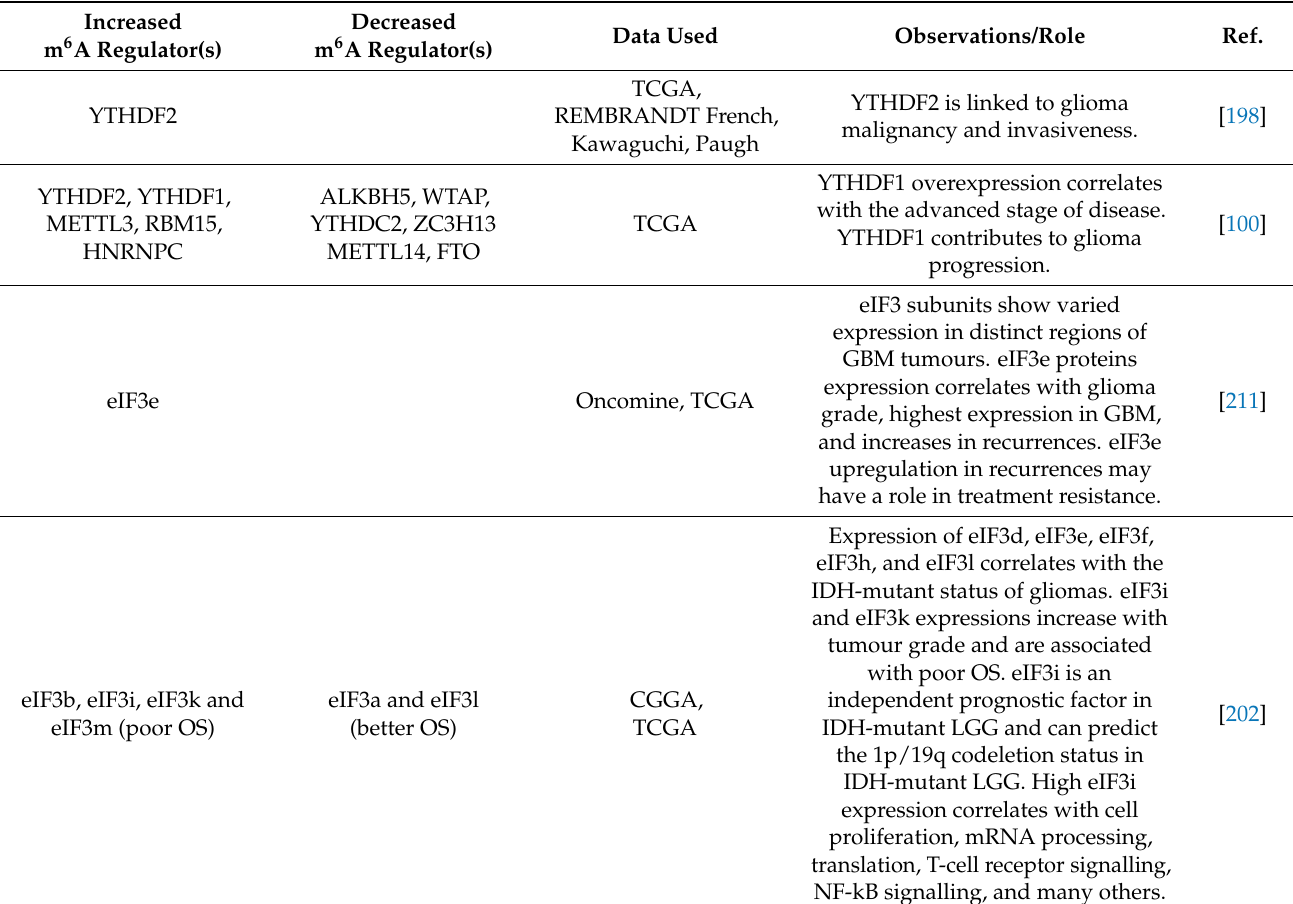
Table 3. m 6 A regulators identified as biomarkers in